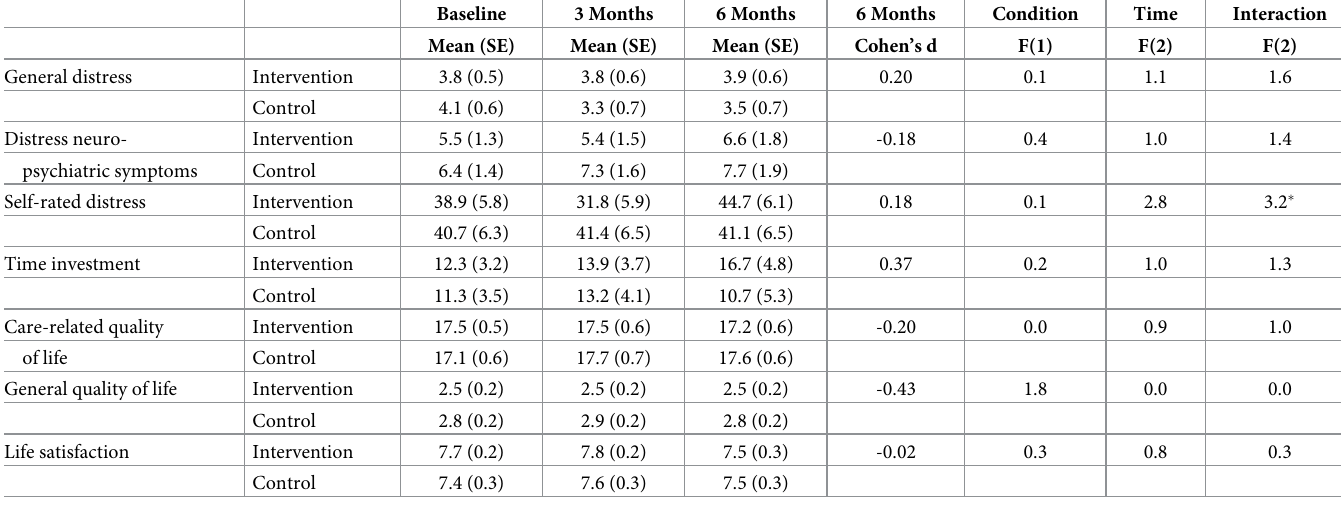
Table 4. Results on secondary outcomes caregiver distress and caregiver quality of life (estimated marginal means).